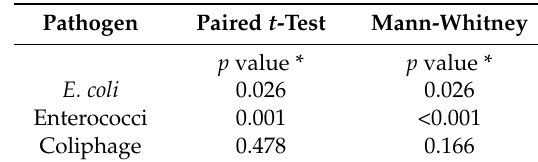
Table 8. Statistical comparison between inflow and outflow concentrations of E. coli , enterococci, and coliphage for three bioretention cells in Grove,